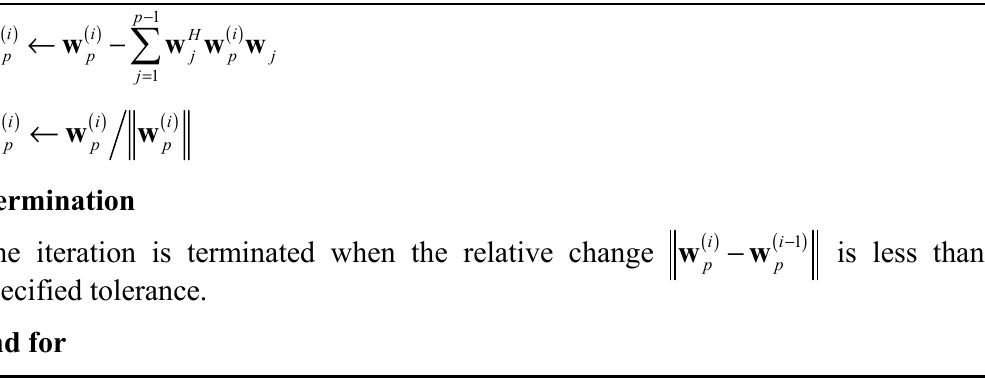
Algorithm 4. The symmetric version of the cICA algorithm with the purpose-designed